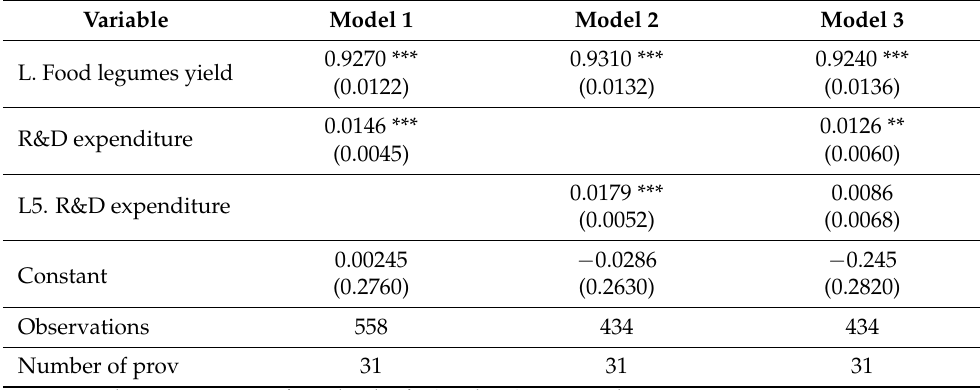
Table 4. Estimation of the yield of food legumes in 31 provinces during 2002–2020.